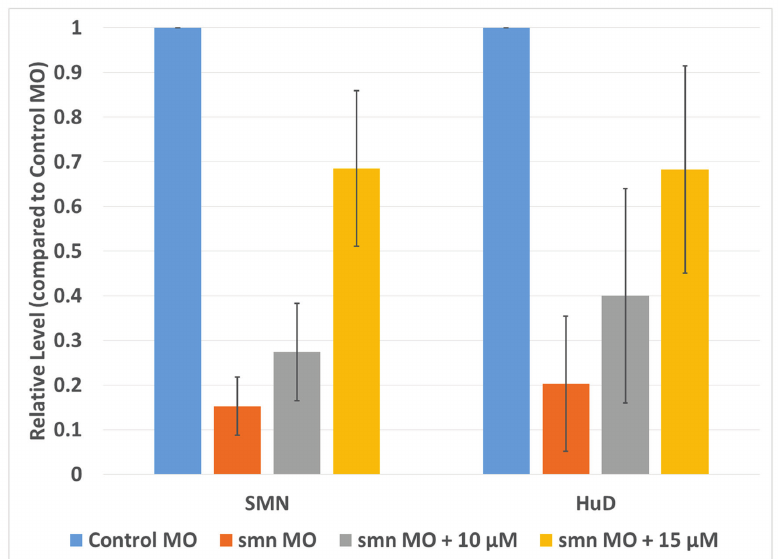
Figure S5. Expression of Smn and HuD in zebrafish embryos. Quantification of western blot results shown in Figure 5C. Treatment of zebrafish embryos with MLN4294 results in approximately a 3-fold increase in both Smn and HuD levels 18 hrs following treatment.